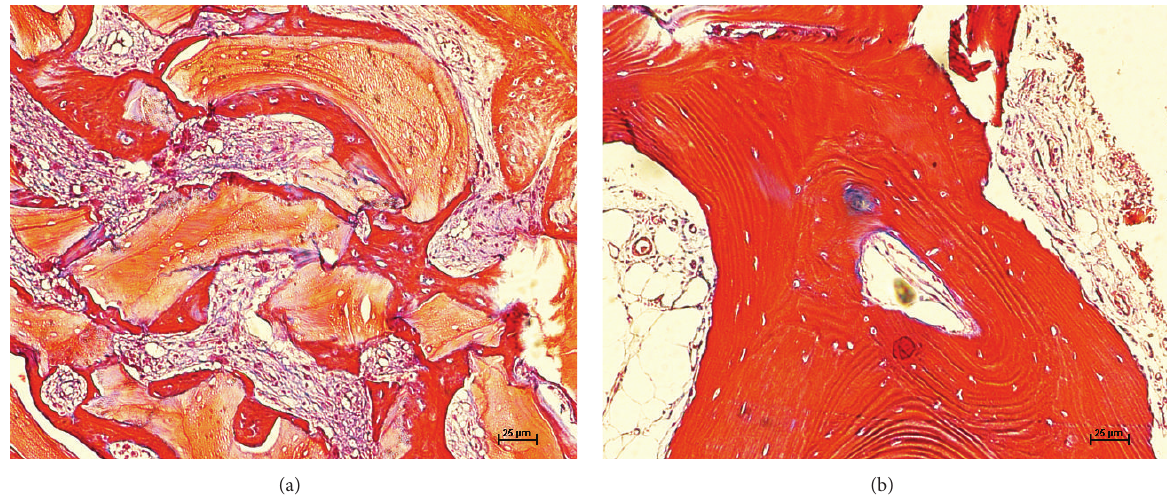
Figure 9: (a) Histological image of control group, stained by Masson’s trichrome technique. Augmentation 20x. (b) Histological image of experimental group, stained by Masson’s trichrome technique. Augmentation 20x.